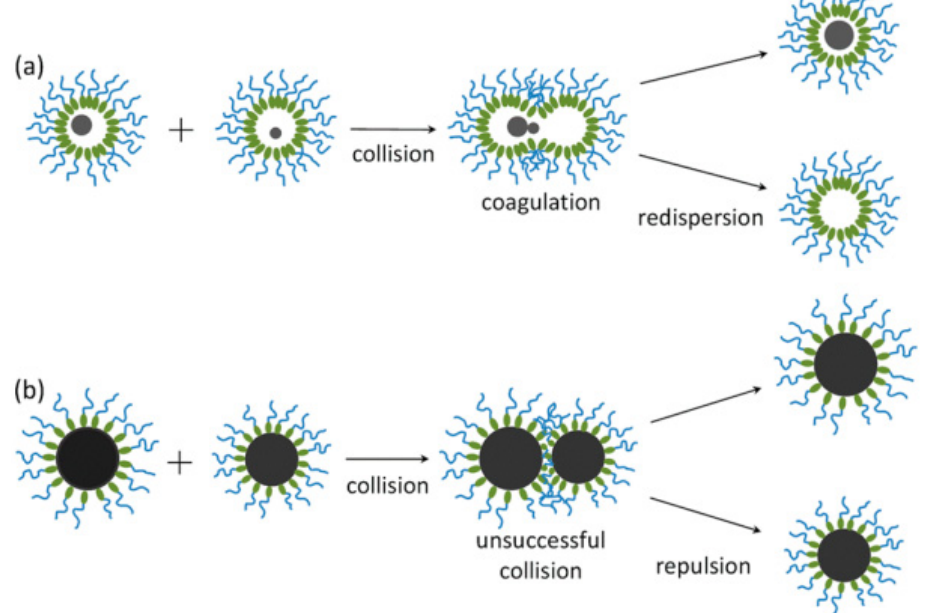
Figure 5. Schematic diagram of particle coagulation in a microemulsion system: ( a ) coagulation of microscopic particles trapped in microemulsion droplets; ( b ) failure of two big colloidal particles to collide. Reprinted with permission from ref. [64]. Copyright 2014 American Chemical Society.